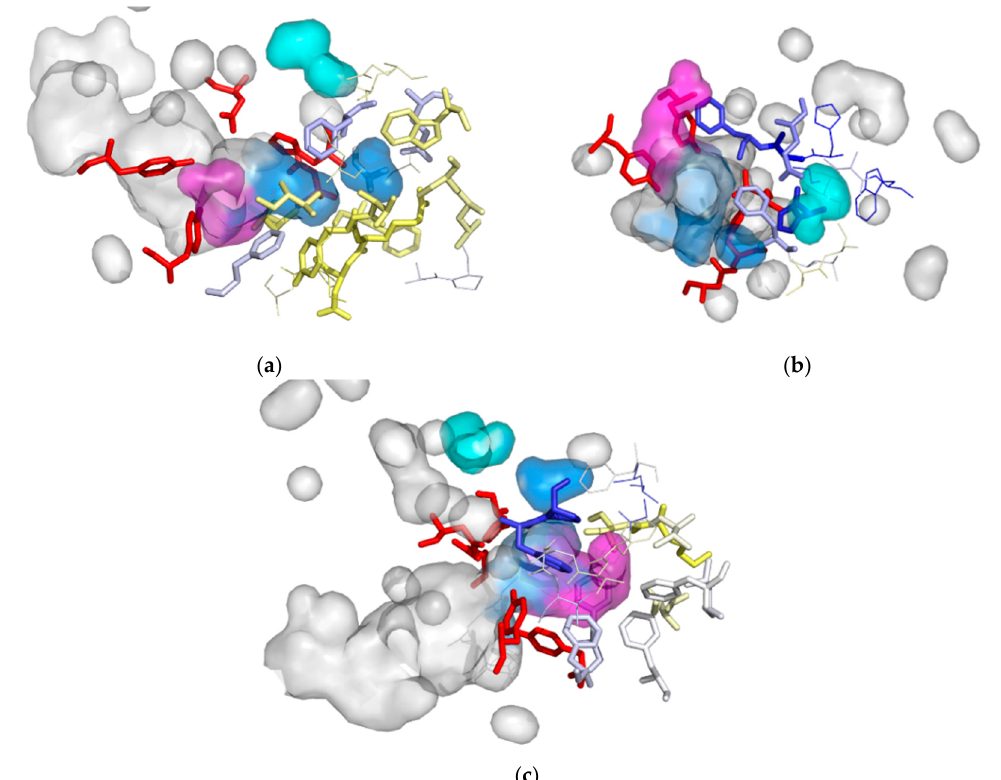
Figure 7. Variability of residues building cavity I ( a ), II ( b ) and III ( c ). Protein interior surface is shown in transparent grey, cavities interior surface area is shown in transparent blue (cavity I), cyan (cavity II) and magenta (cavity III), active site residues shown as red sticks, the amino acids composing cavities are coloured according to their entropy score and are shown as sticks (for frequently detected) or lines (rarely